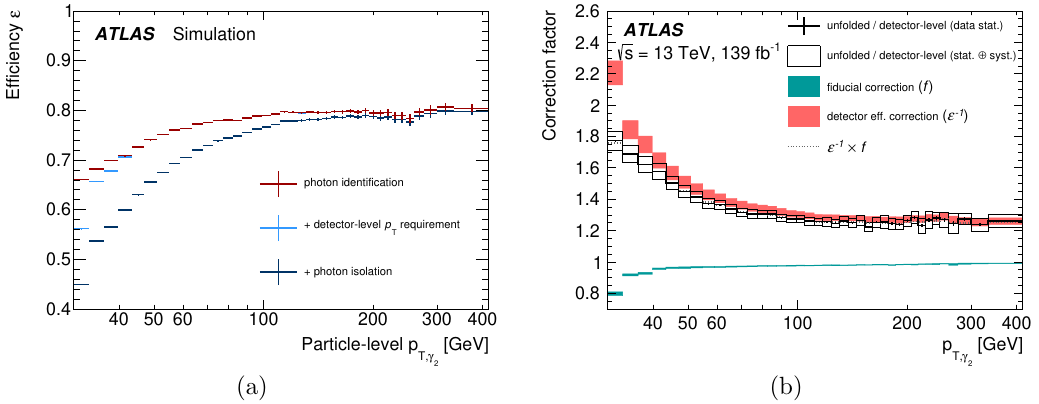
Figure 8. (a) Efficiency of consecutive sets of detector-level selections for diphoton events passing the particle-level selection as a function of the particle-level p the detector-level yields after background subtraction as a function of p fraction of non-fiducial events not passing the particle-level cuts is depicted in green. The correction for the detector efficiency is shown in red. The black line is the ratio of the detector-level yields to the result after the three corrections (i.e. for non-fiducial events, the iterative migration unfolding and the correction for detector inefficiencies) are applied. The impact of the iterative unfolding can be seen by comparison with the grey dotted line, which is the product of the efficiency and fiducial